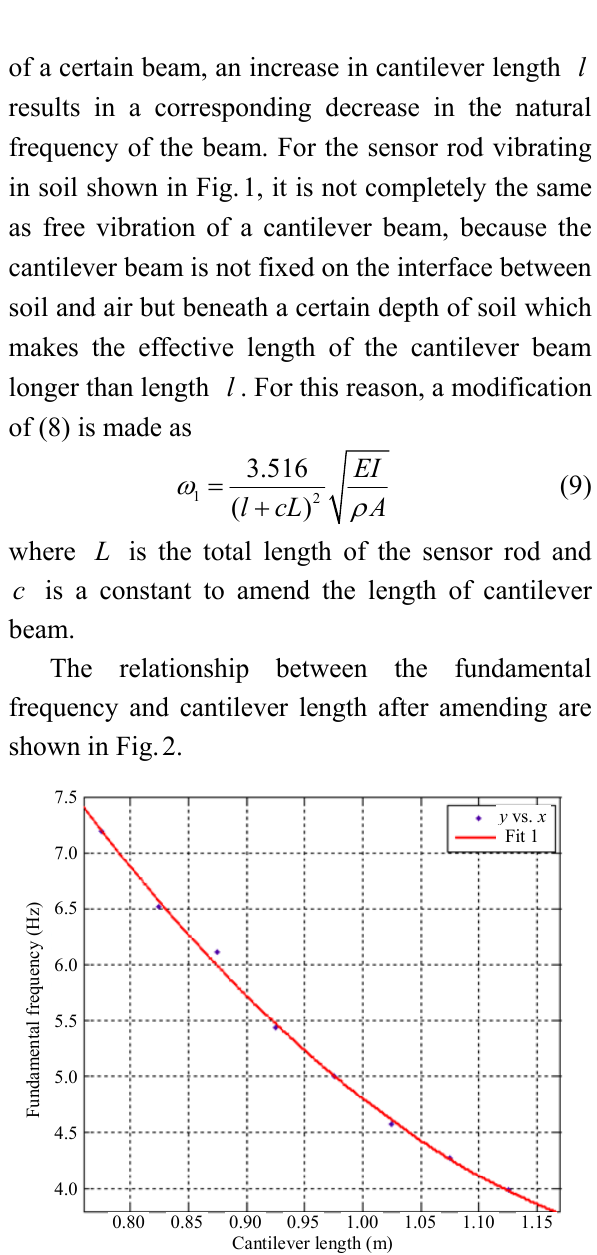
Fig. 2 Relationship between fundamental frequency and cantilever length of the beam.